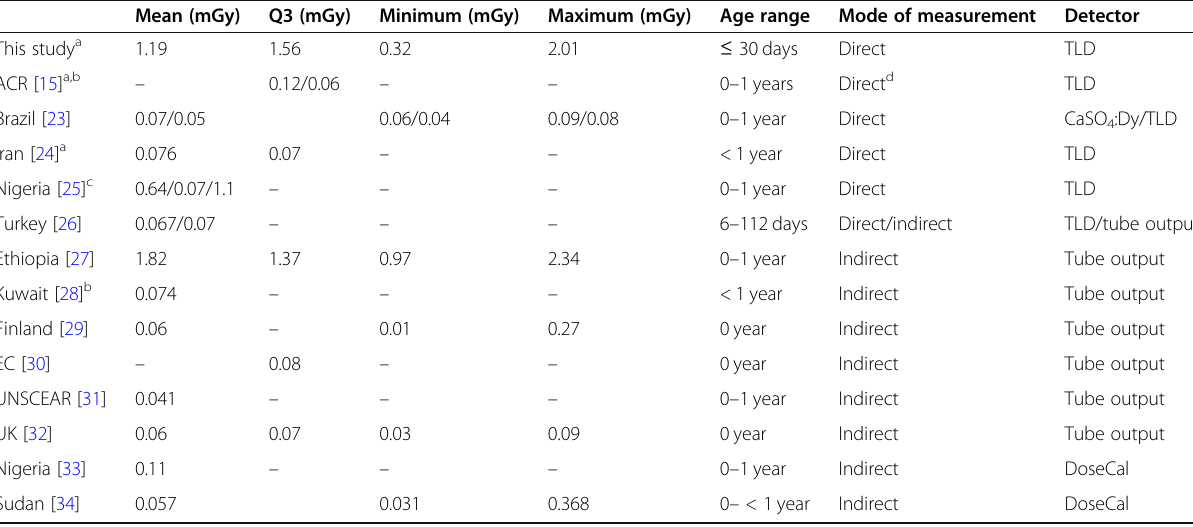
Table 7 Comparison of this study ’ s ESD with other national and international studies Mean (mGy) Q3 (mGy) Minimum (mGy) Maximum (mGy) Age range